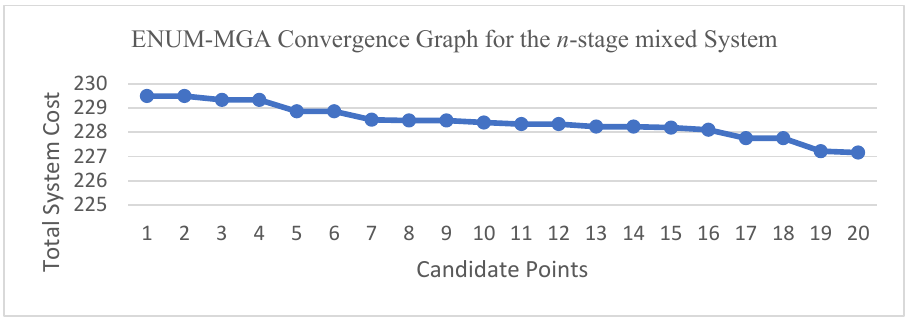
Figure 18. The convergence graph of the n -stage mixed system by enforcing the ENUM-MGA combined method. Table 36. Optimal Solutions obtained by ENUM–MGA combined method for the n -stage mixed system.